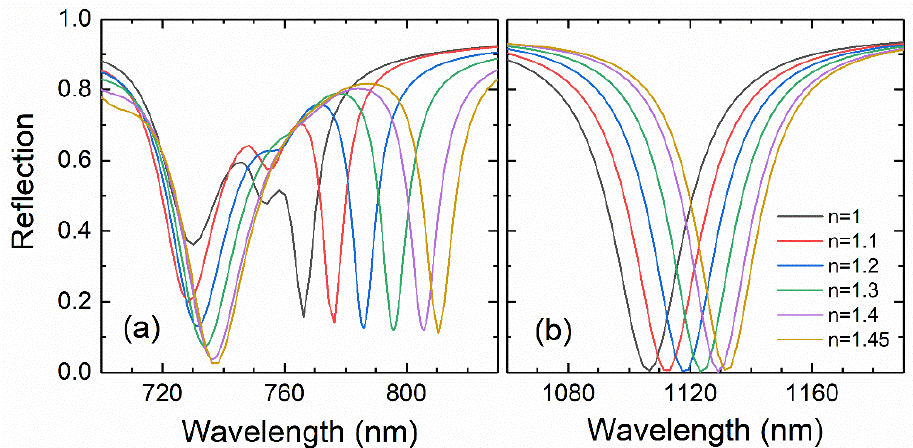
Figure 4. Reflection spectra around the wavelength ranges where the SLRs corresponding to the top ( a ) and bottom ( b ) interfaces of the Au inverted honeycomb lattice take place. The spectra were simulated for several values within 1.1 and 1.45 of the refractive index of a test layer of 50 nm in thickness resting on top of the heterostructure. The spectrum in Figure 2 without the test layer is included as a reference (black line).